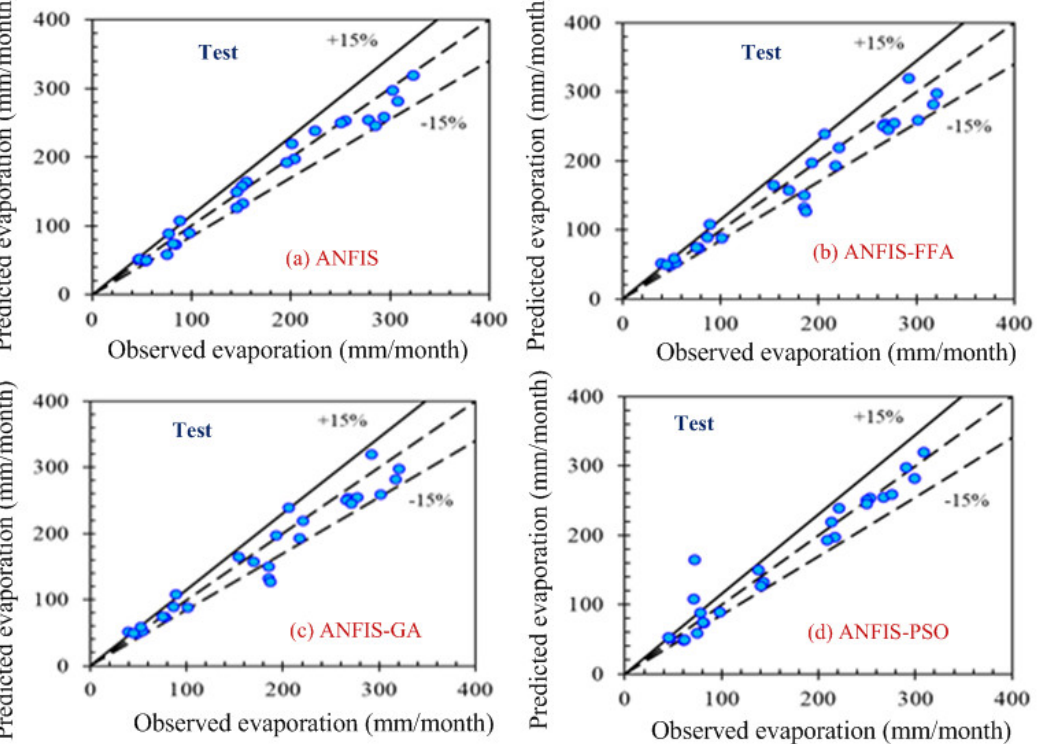
Figure 7. Comparison of the target and obtained output sample index of the test data for ( a ) ANFIS, ( b ) ANFIS–FFA, ( c ) ANFIS–GA, and ( d ) ANFIS–PSO, respectively (second combination of the data set).